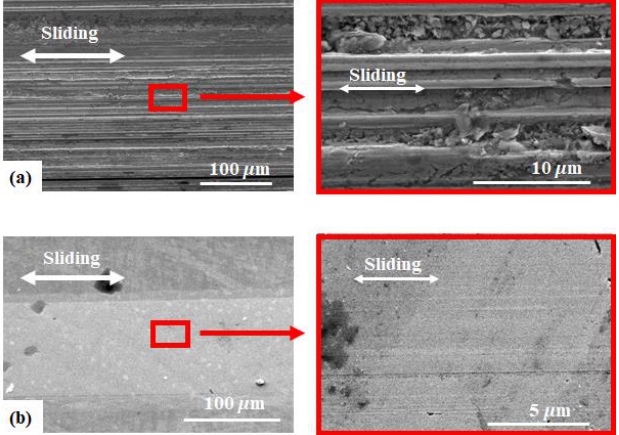
Figure 12. The SEM images of the worn surface of ( a ) crystalline Pd and ( b ) amorphous Pd alloy samples with the ionic liquid at 200 °C and the sliding speed of 7 mm/s.